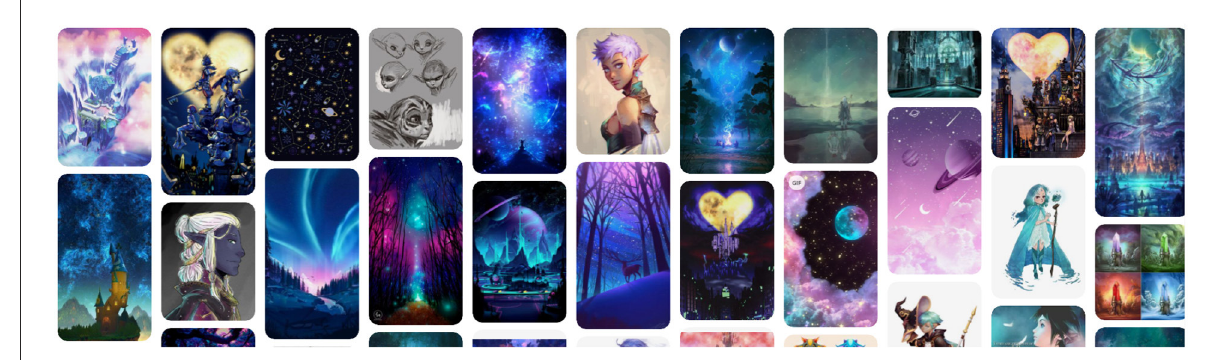
FIGURE7 Part of the moodboard created for the Motion Hollow experience. The inspirational moodboard was created on Pinterest, and its full version can be found at